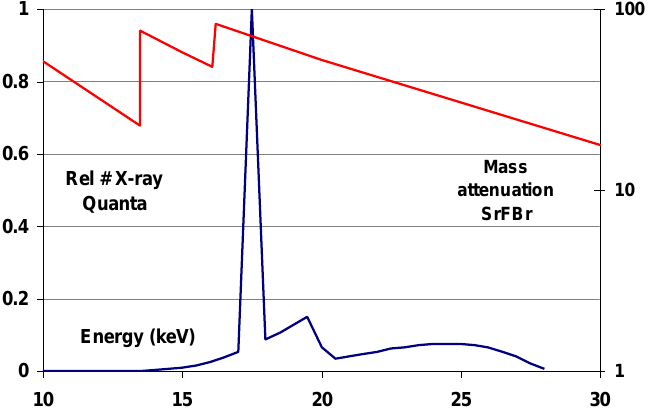
Figure 17. Overlay of the mass attenuation coefficient of SrFBr and a typical mammography X-ray